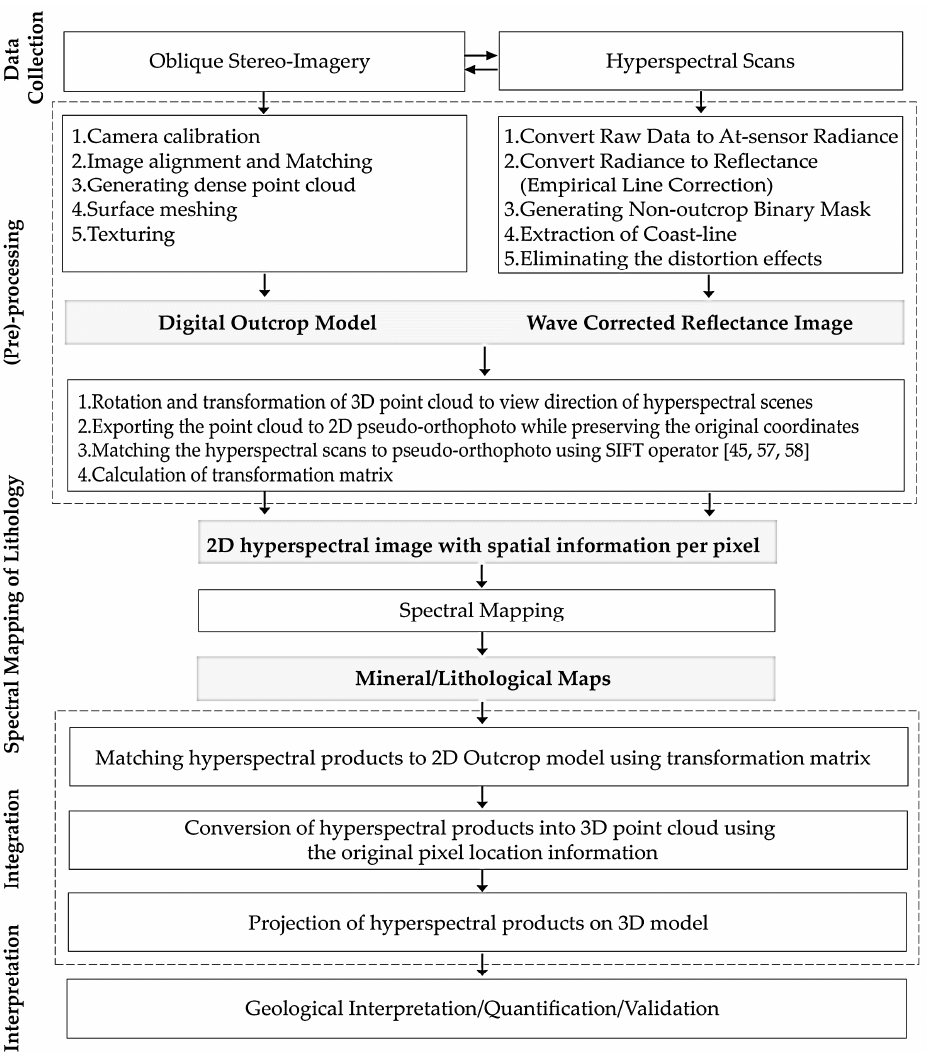
Figure 3. Flowchart of the analysis design and methods applied for integration of hyperspectral products and 3D-photogrammetric terrain data.